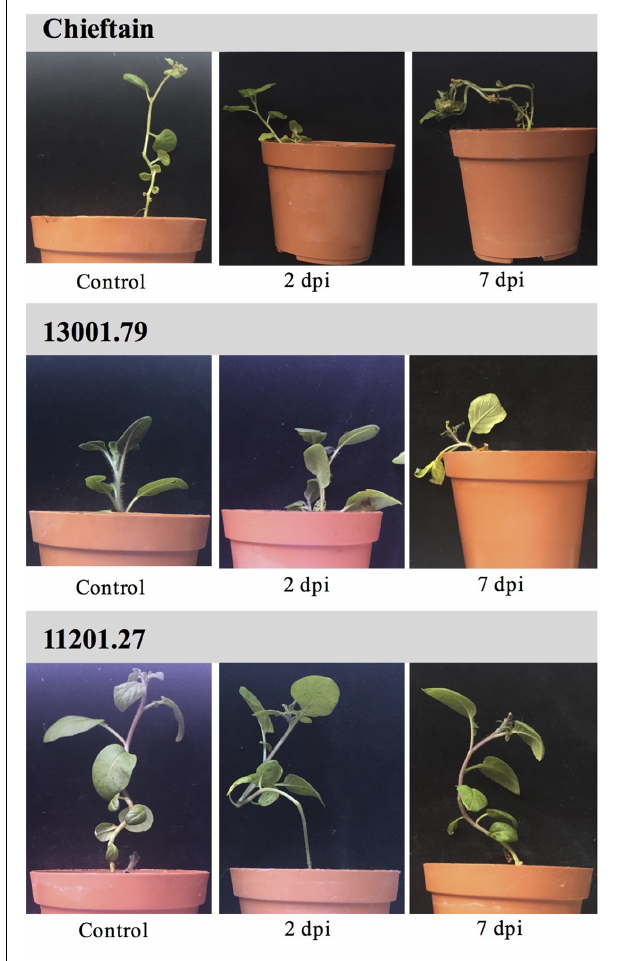
FIGURE 3 | Symptom evaluation of bacterial wilt on potato plants soil inoculated with R. solanacearum strain UY031 Pps-GFP. Light pictures of plants from susceptible potato cultivar S. tuberosum cv. Chieftain, the susceptible clone 13001.79 and the tolerant clone 11201.27 were taken 2 and 7 days post inoculation (dpi). Control: mock inoculated plants of each